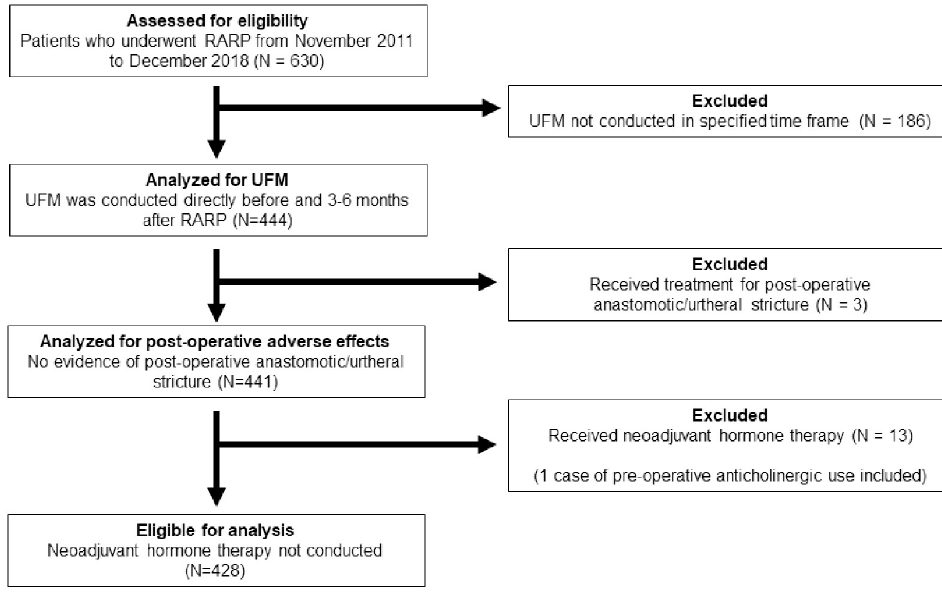
Fig 1. Diagram of patient